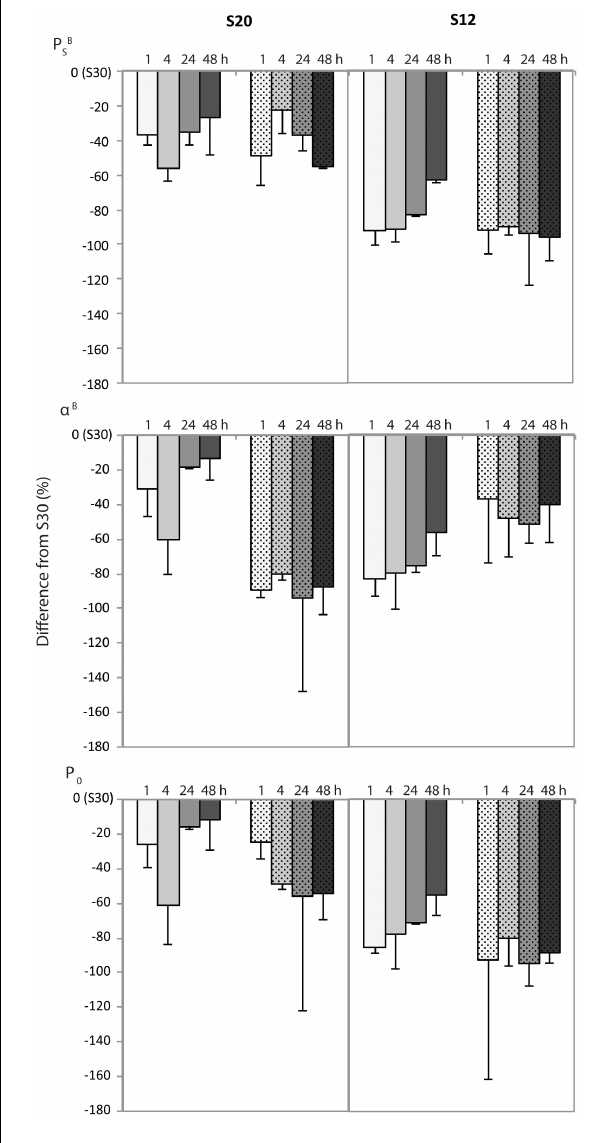
FIGURE 6 | Percent difference in the average ( n = 2) of select photosynthetic parameters (see text for definitions) with standard deviation between algae grown in salinity 30 (S30) versus 20 (S20) and 12 (S12). Differences are plotted over experimental time intervals 1, 4, 24, and 48 h for samples grown at 30 µ mol m − 2 s − 1 (solid fill) or in the dark (patterned